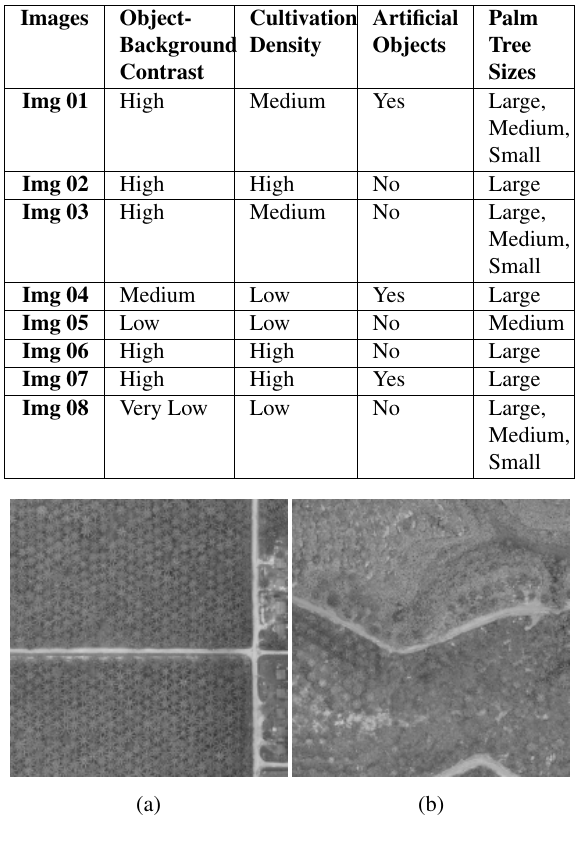
Figure 8: (a) Test Image 07 (b) Test Image